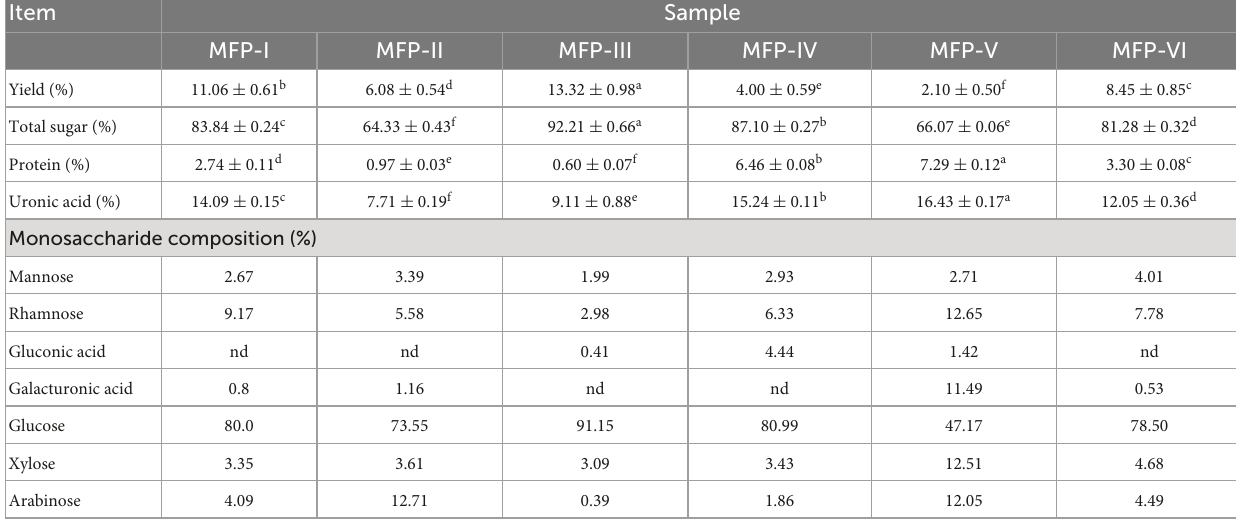
TABLE 1 The chemical compositions and monosaccharide composition of MFP obtained by different extraction methods. Item